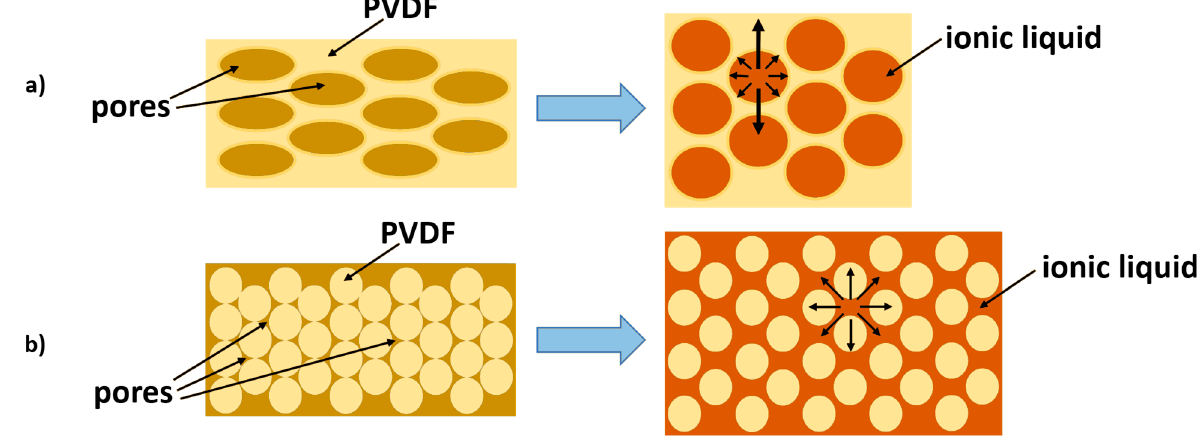
Figure 2. Impregnation of polymer membrane with: ( a ) sponge structure and ( b ) spherulite structure.